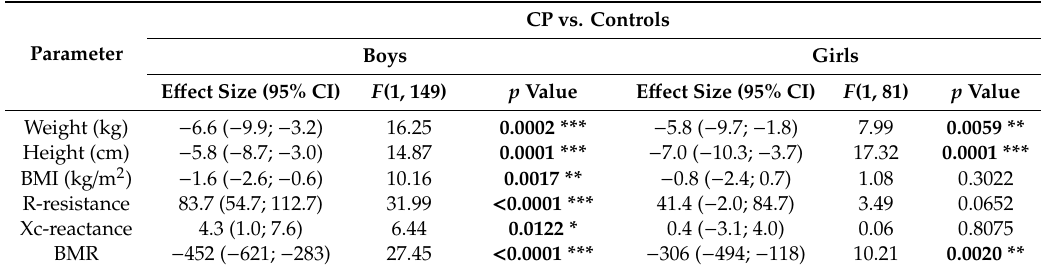
Table 1. Anthropometric parameters of the study and control groups—estimation of di ff erence between CP and controls using ANCOVA model with age as